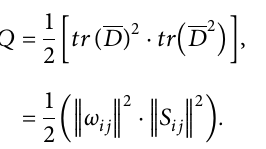
Figure 6: The vortex distribution in the middle section of impeller under different working conditions. (a) Q � 0.4 Q (c) Q � Q d